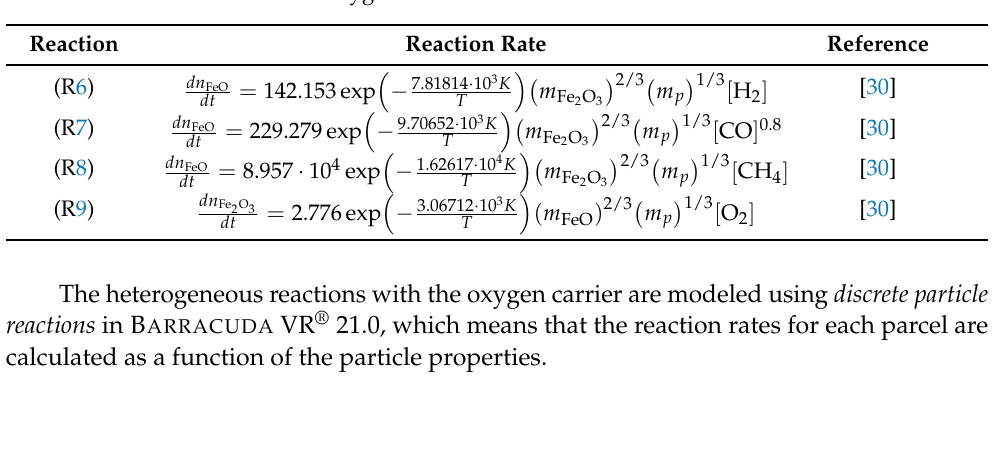
Table 4. Reaction kinetics of the oxygen carrier